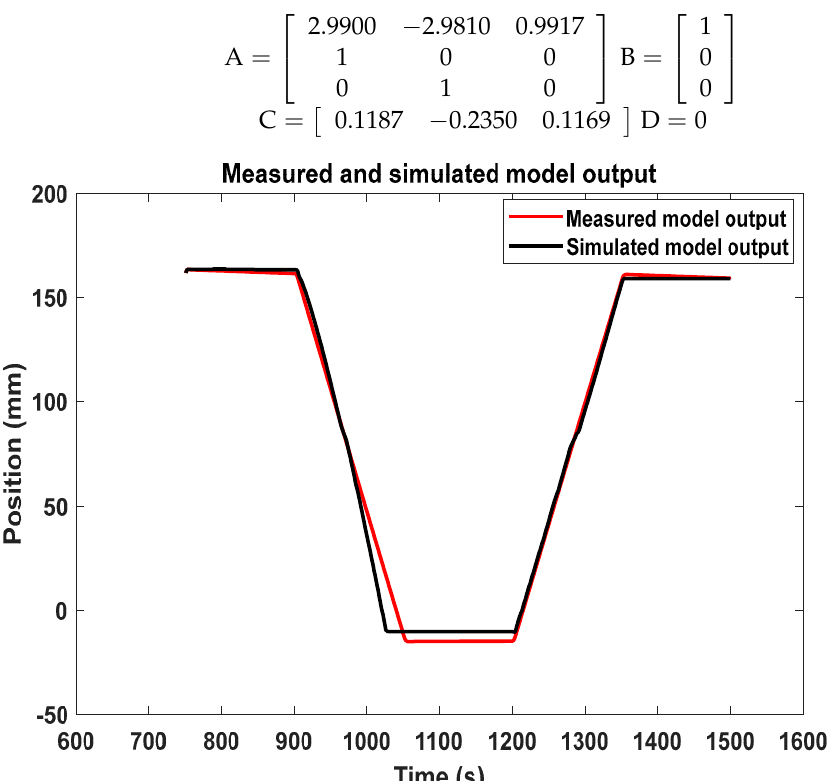
Figure 4. The output of the model, both measured and simulated.